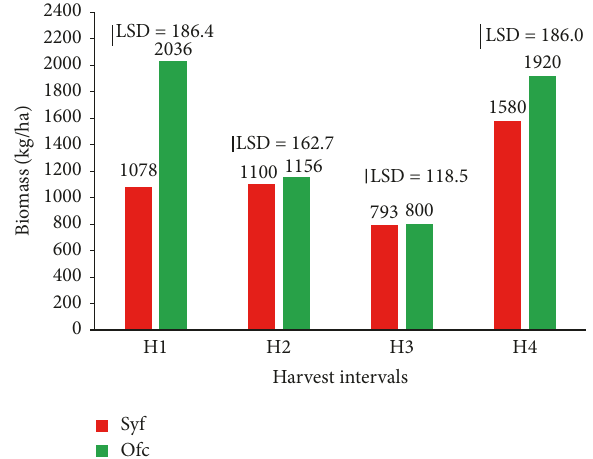
Figure 3: Biomass production of moringa at four harvest intervals at Syferkuil and Ofcolaco across the four seasons irrespective of the planting density. LSD: least significant difference. H1: harvest 1;